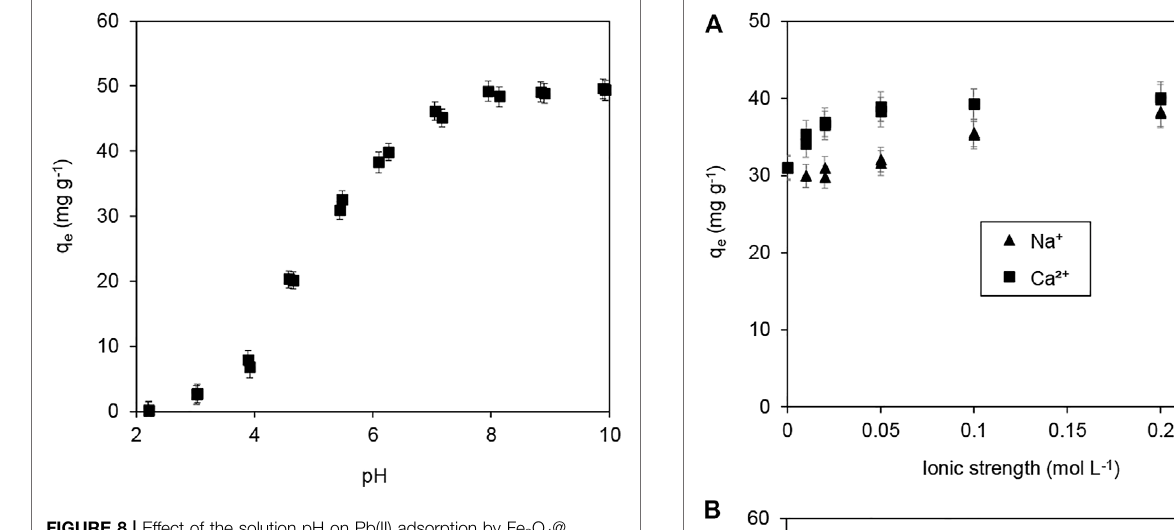
FIGURE 8 | Effect of the solution pH on Pb(II) adsorption by Fe 3 O 4 @ SiO 2 -MnO 2 (1.54). (C 0 (Pb(II) = 25.0 mg L − 1 , adsorbent dosage = 0.5 g L − 1 , Temperature = 25 ° C).